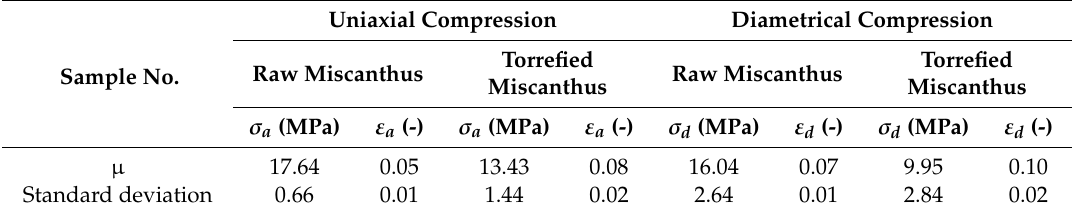
Figure 12. Mechanical durability values of raw and torrefied miscanthus pellets. Error bars show the standard deviation. Table 3. Maximum stress and strain at failure for uniaxial and diametrical compression tests of raw and torrefied